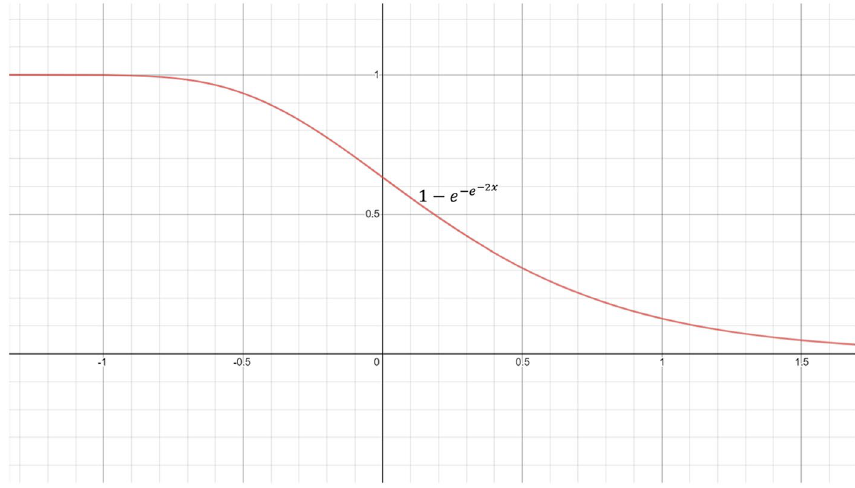
Figure 9. Displaying the re-parameterized Gompertz function used in the present